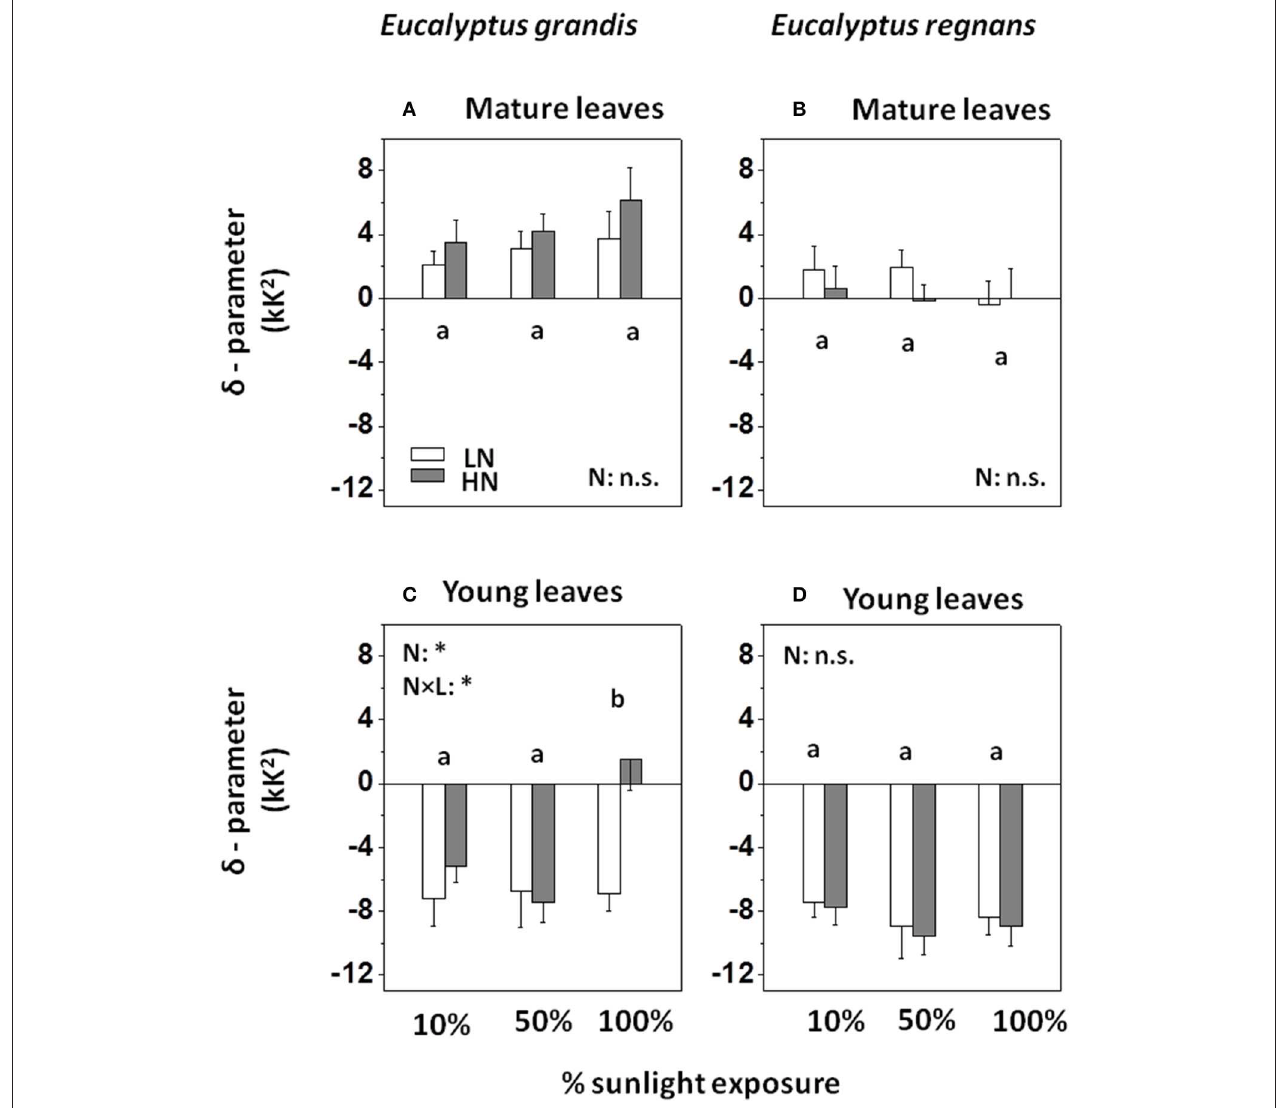
FIGURE 6 | Temperature dependency of activation energy ( δ R ) of mitochondrial O 2 -reduction in Eucalyptus grown under differing N-nutrition and light intensity. (A) Dynamic change of µ (or respiratory activation energy, E o ) with measurement temperature, captured by δ -parameter of mature Eucalyptus grandis leaves. (B) Respiratory δ -parameter for mature Eucalyptus regnans leaves. (C) Respiratory δ -parameter for young Eucalyptus grandis leaves. (D) Respiratory δ -parameter for young Eucalyptus regnans leaves. Open columns: “low” N-supply (LN: 2.6mM N). Gray columns: “high” N-supply (HN: 8mM N). Each column shows the average ± SE of six independent replicates. Different letters indicate significant differences between light regimes within species ( N = 12 for each factor group; post-hoc Tukey HSD-test). Asterisk (*) indicates significant N-treatment effect ( N = 18 for each factor group; n.s., not significant). For effect sizes between species and treatments (and leaf developmental stage), see Table 3